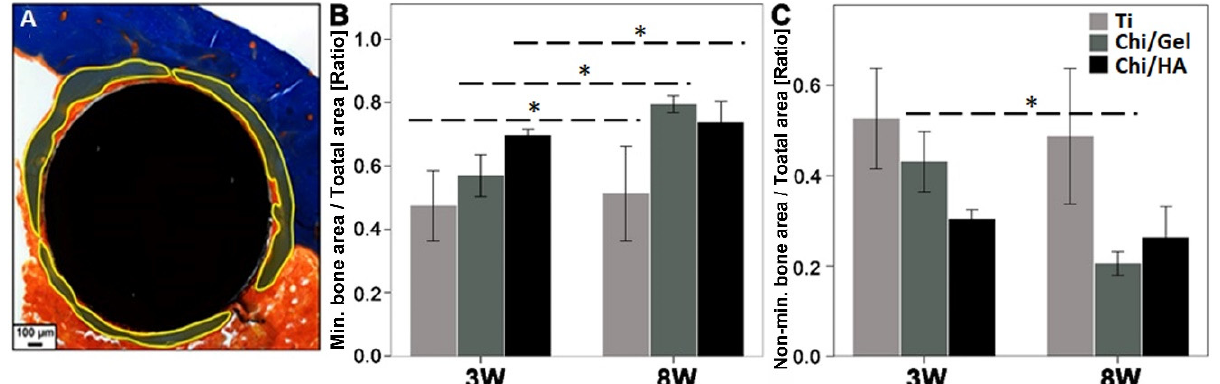
Figure 1. Higher amount of mineralized bone matrix seen within bone-implant interface after 8 W. Changes in matrix mineralization were evaluated using histological analysis. ( A ) Modified Masson Goldner stain helped in the quantification of mineralized and non-mineralized bone matrix area. ( B ) Chi/Gel group showed significantly higher mineralized bone matrix after 8 W compared with 3 W. Although not as apparent as the Chi/Gel group, Ti and Chi/HA groups also showed a higher mineralized bone matrix area after 8 W, ( C ) Chi/Gel showed a significantly lower portion of non- mineralized bone matrix area after 8 W compared with 3 W. Chi/HA group also showed lower non- mineralized bone area after 8 W (Ti: n = 5 (3 W), n = 3 (8 W); Chi/Gel: n = 5/time point; Chi/HA: n = 4 (3 W), n = 5 (8 W); *: p ≤ 0.05).